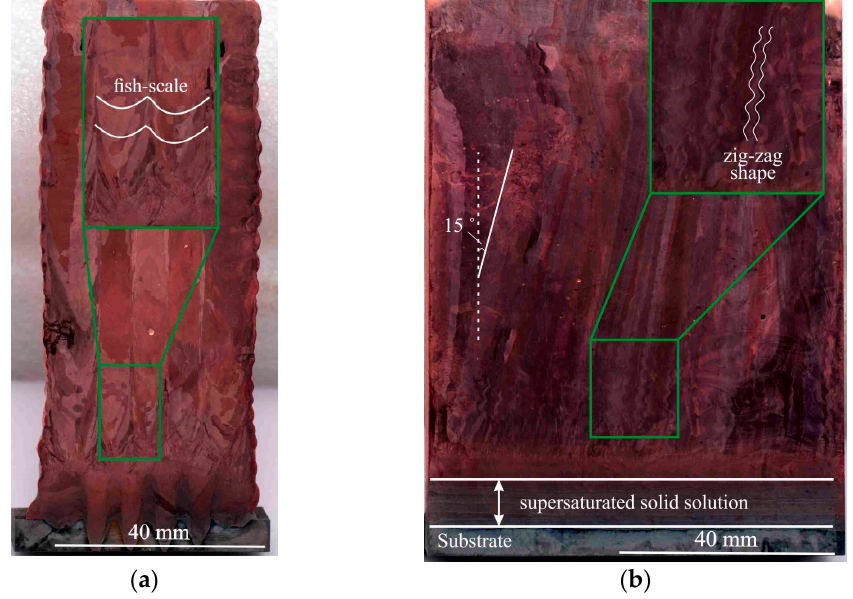
Figure 7. Macrostructure of the C-type copper block in cross- ( a ) and longitudinal sections ( b ). The green rectangle indicates the enlarged area showing the fish-scale and zig-zag shape of the structure.